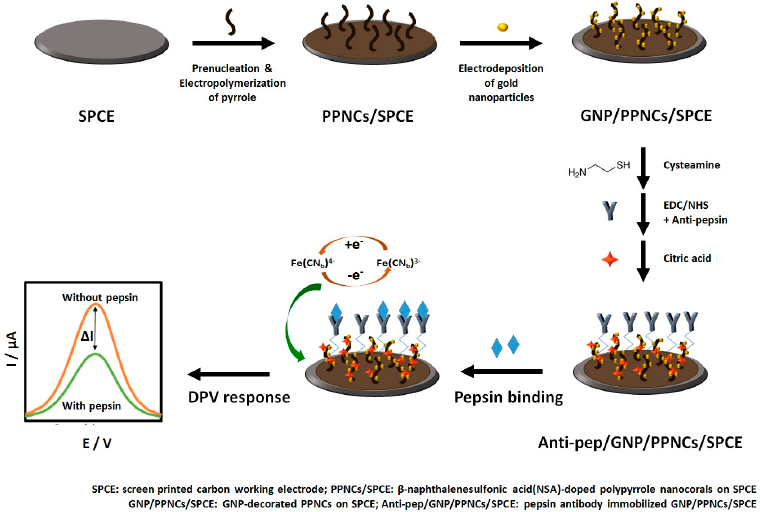
Figure 1. Schematic illustration of the fabrication process of the electrochemical immunosensor based on GNP/PPNCs/SPCE for pepsin detection.